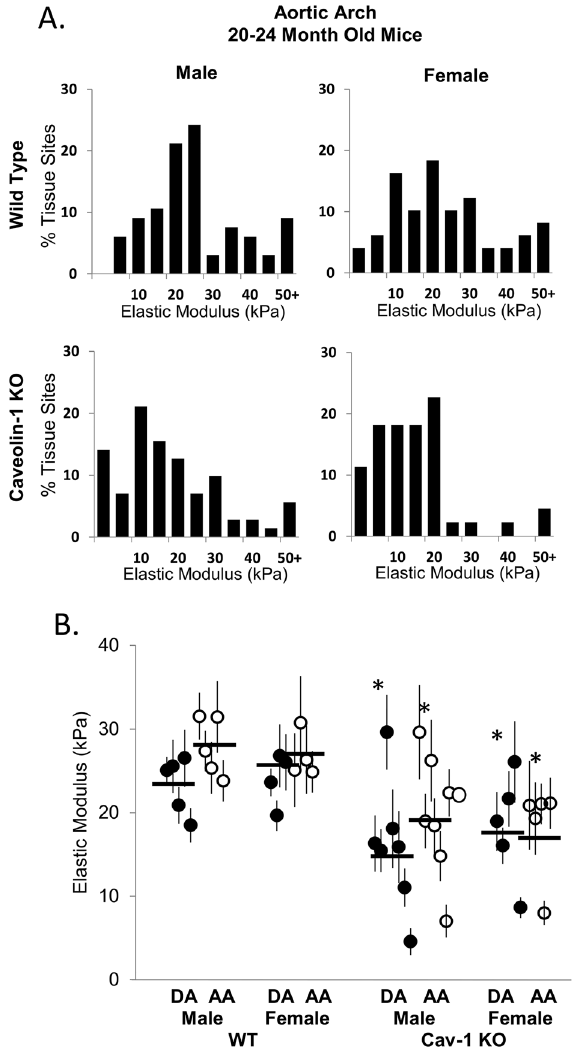
Figure 7. Cav-1 deletion in advanced aged mice reduces endothelial stiffening and no elastic modulus differences between the sexes. ( A ) Histograms of elastic modulus values from the aortic arch of advanced age (20–25 months) WT and Cav-1 KO males as compared to females with ( B ) Data summary of descending aorta and aortic arch from AFM recording in male and female WT and Cav-1 KO mice (n = 4–7 mice, 10–20 measurements per sample). *P < 0.05 compared to same vessel type and sex in WT mice as tested by ANOVA and a Student’s